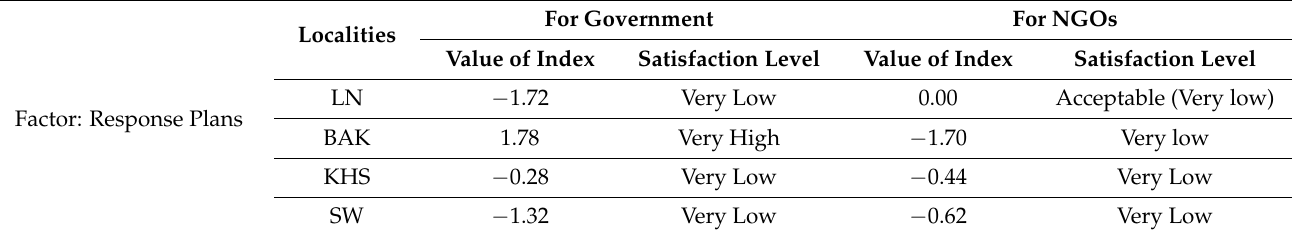
Table 3. Comparison of satisfaction level against flood response received after the 2010 floods between Government and NGOs.